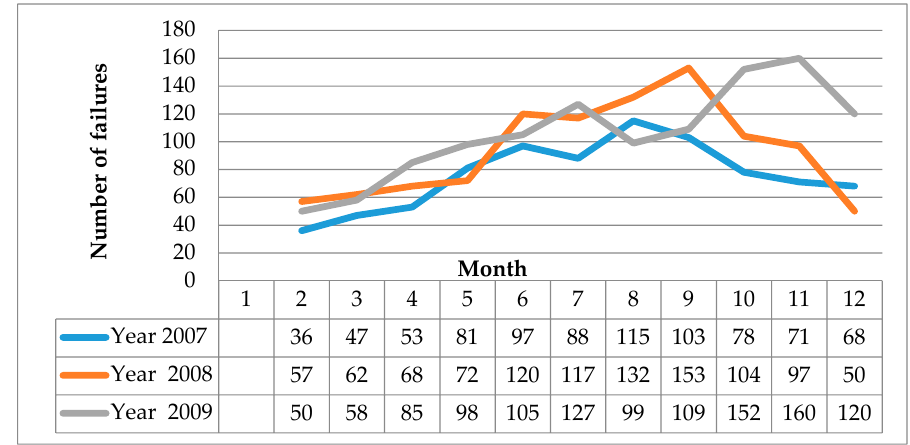
Figure 2. Monthly evolution of failures that occurred in the water supply network of Cluj-Napoca, February 2007–December 2009 [14].